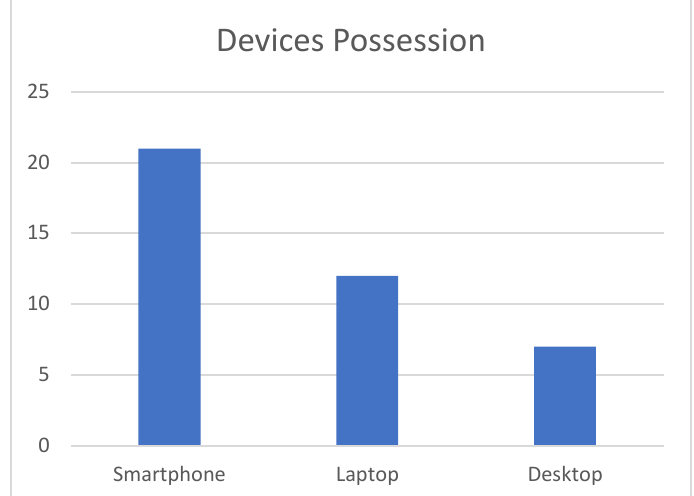
Figure 5. Possession of devices